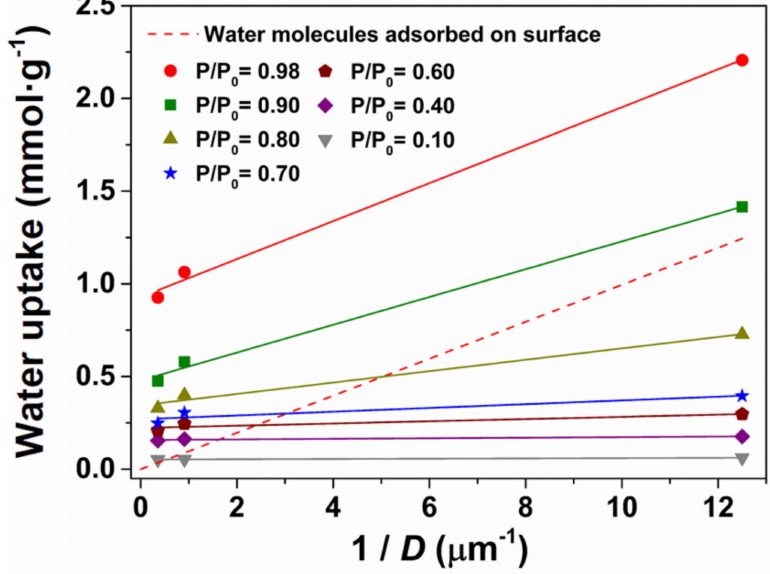
Figure 4. Water uptake at variable P / P 0 plotted as a function of the particle size of ZIF-8, compared to a prediction assuming a monolayer of water covering the external particle surface (dashed